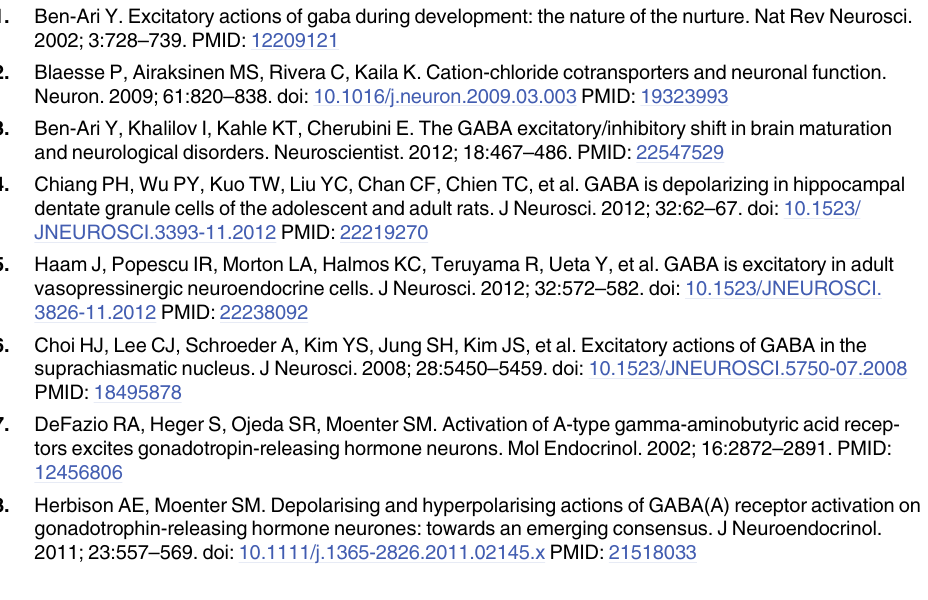
S2 Fig. AE3 is not detected the cell soma or processes of GnRH neurons. A) AE3 (red) was not detected in GnRH neurons (green) in adult mice. B) GnRH fibers (green) in the median eminence of pre-pubertal (PN11; B1) and adult mice (B2) were also negative for AE3 (red), which is highly expressed in the outer region of the median eminence. Scale bars: A = 10 μ M, B = 100 μ